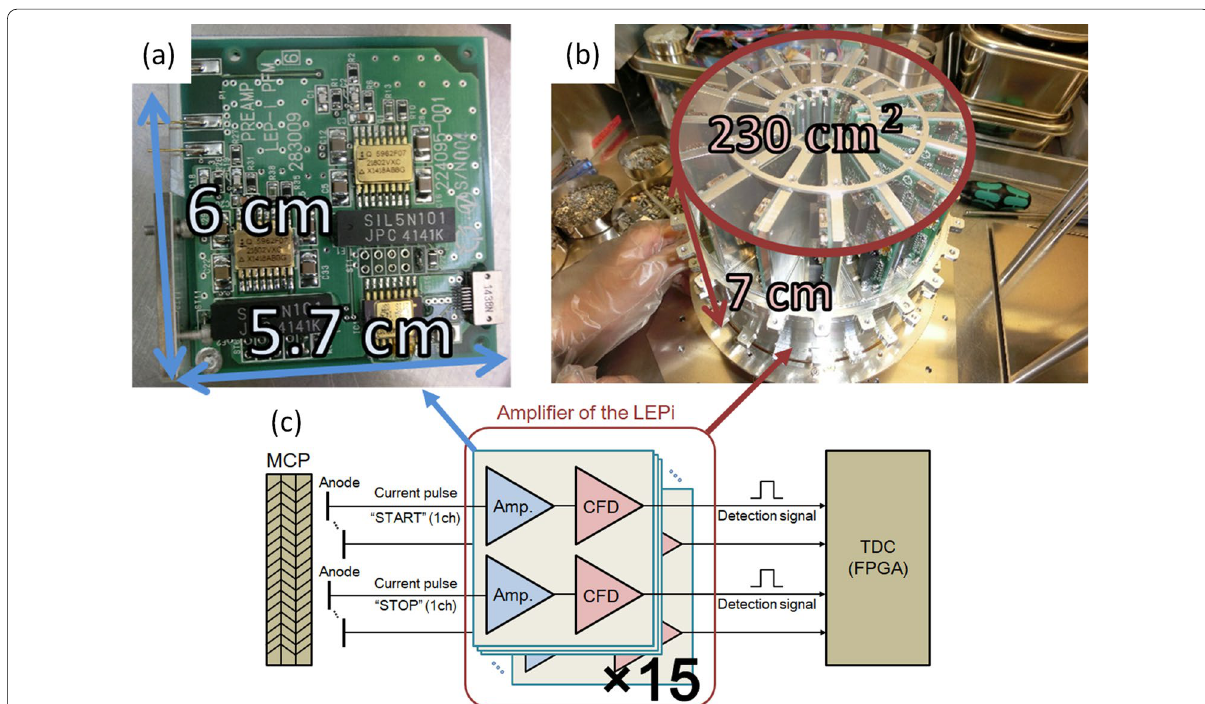
Fig. 2 Amplifiers used in the LEPi onboard the Arase satellite. a One channel of amplifiers combined on a single board ( 6.0cm × 5.7cm ). b Overview of amplifiers with 15 boards arranged azimuthally ( 230cm 2 (total area of the bottom) × 7cm (height)). c Circuit block diagram of the amplifier. The LEPi has 15 channels that discriminate the incoming directions of particles. Each channel contains MCP anodes for START and STOP signals, respectively. The anodes receive the electron clouds emitted from the MCP. Each amplifier, which consists of a preamplifier and a constant-fraction discriminator (CFD), is connected to an anode. Two amplifiers are installed on a single board, for a total of 30 amplifiers in the LEPi. The output signal of the amplifier is fed into the TDC in the subsequent stage (Asamura et al.